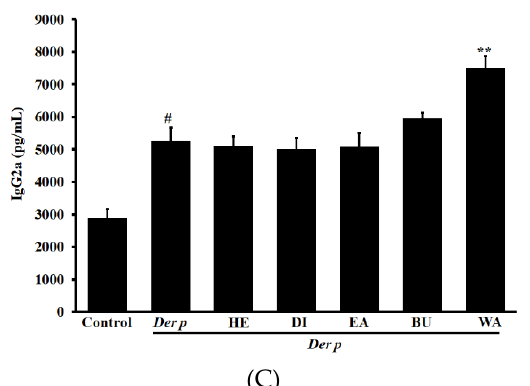
Figure 4. Effects of different fractions of garlic extracts (80 mg/kg) on serum ( A ) IgE, ( B ) IgG1 and ( C ) IgG2a in mice with Der p–induced allergic asthma. Data are expressed as mean ± SEM. # p < 0.05 and ### p < 0.001 versus the control group, * p < 0.05 and ** p < 0.01 versus the Der p group.